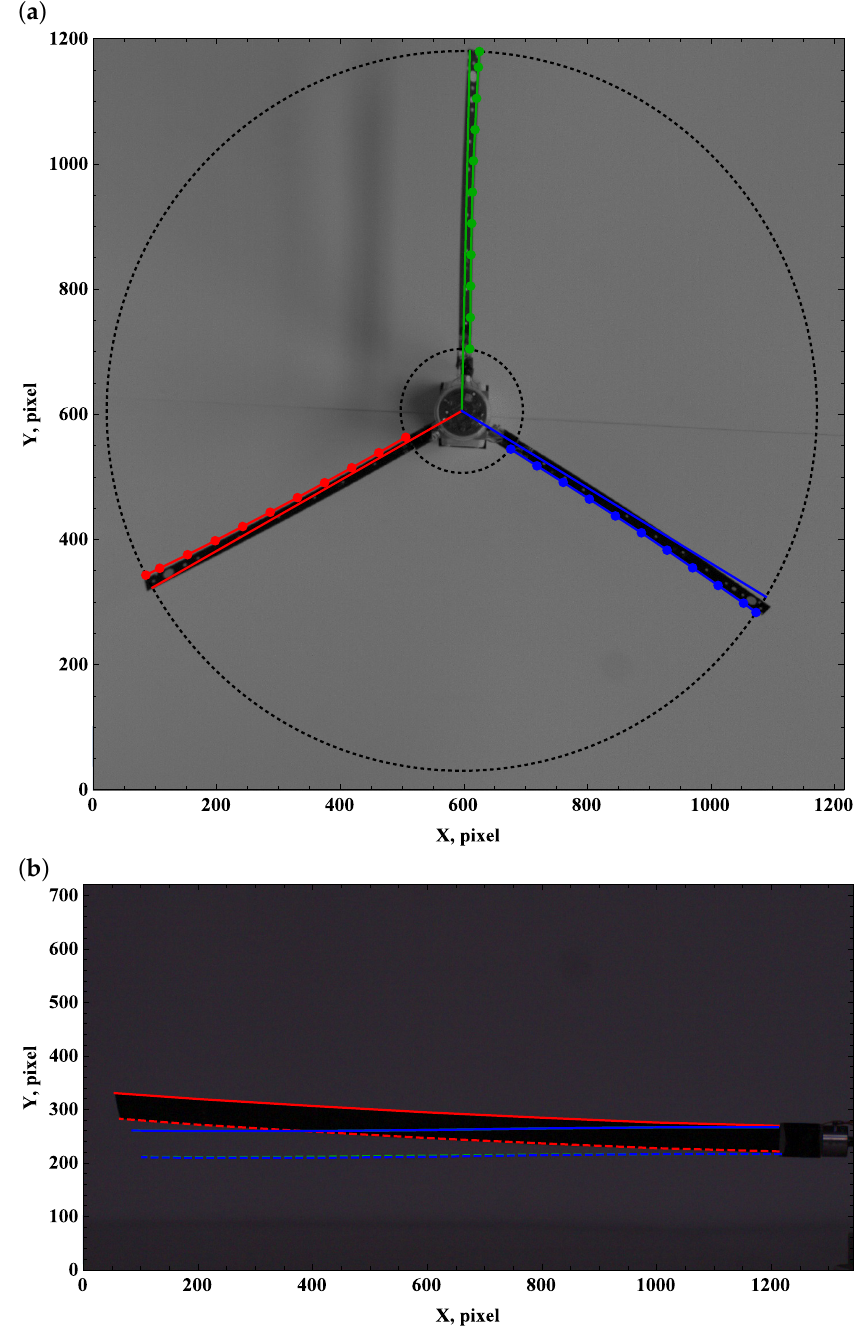
Figure 9. Preset angle 45 ◦ , angular speed 50 rpm: top view ( a ), side view ( b